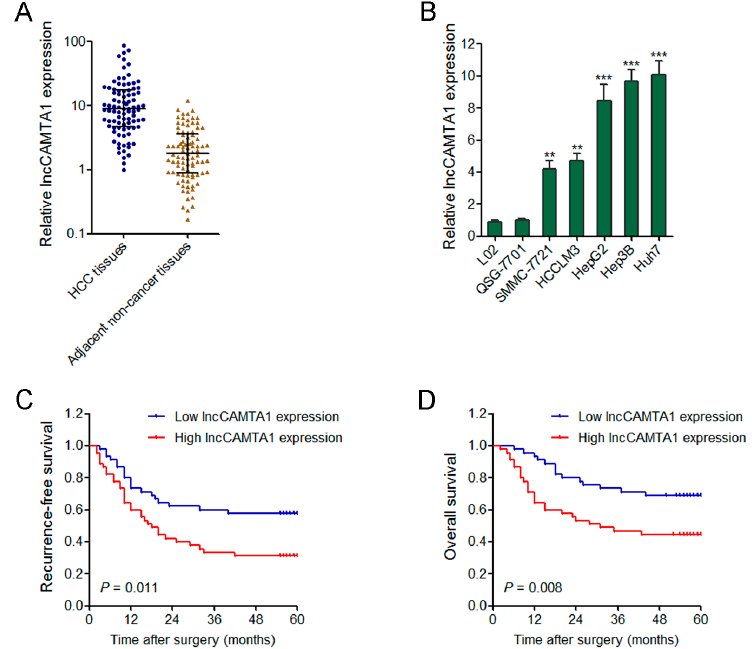
Figure 3. lncCAMTA1 is increased in HCC and indicates poor outcome. ( A ) lncCAMTA1 is increased in HCC tissues in comparison with paired adjacent non-cancerous hepatic tissues. Data are shown as median with interquartile range. n = 90, p < 0.001 by Wilcoxon signed-rank test; ( B ) lncCAMTA1 is increased in HCC cell lines SMMC-7721, MHCC97H, HCCLM3 and HepG2, in comparison with normal liver cell lines L02 and QSG-7701. Data are shown as mean ± SD from at least three independent experiments. ** p < 0.01, *** p < 0.001 by Student’s t test; ( C , D ) Kaplan–Meier analyses indicated that patients with high expression of lncCAMTA1 had a shorter recurrence-free survival ( p = 0.011, log-rank test); ( C ) and overall survival ( p = 0.008, log-rank test); ( D ) time than those with low expression of